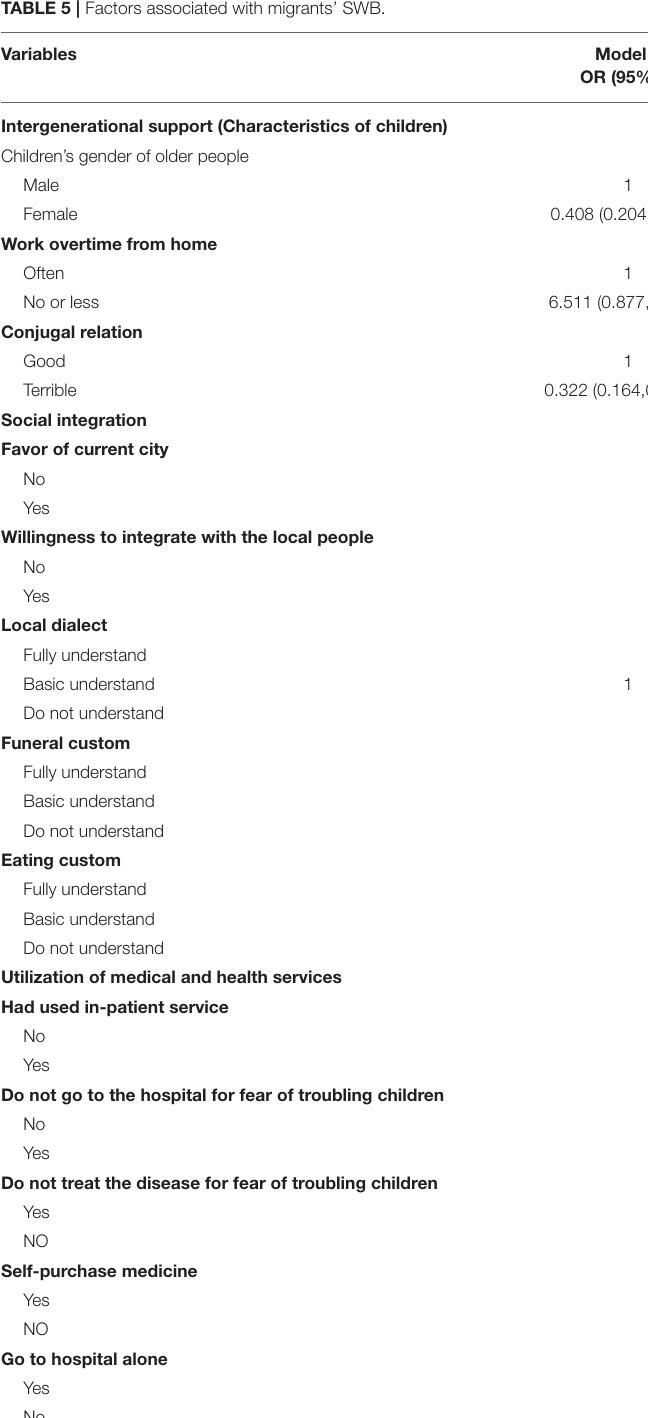
Model 3 OR (95%CI)